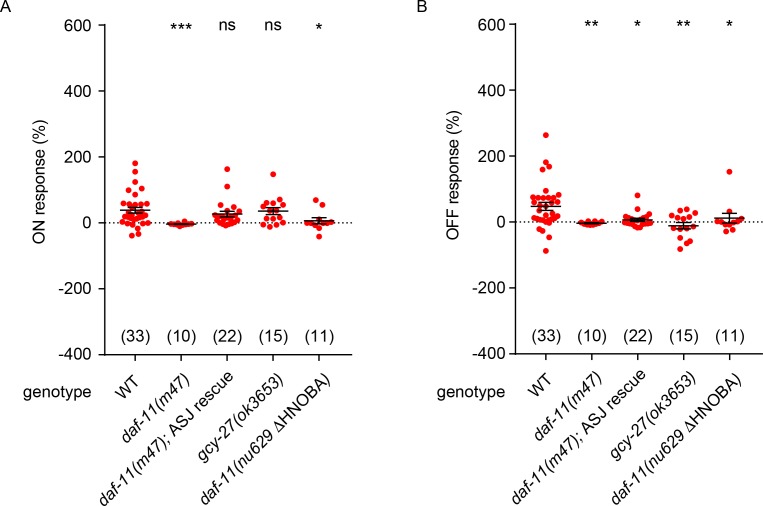
NO response amplitudes for data in Figure 5.(A, B) NO evoked ON (A) and OFF (B) response amplitudes (scatter plots and mean ± SEM) are shown for recordings in Figure 5. ON and OFF response amplitudes are defined in the Methods. For statistical analysis, responses of all mutant genotypes in Figures 4–7 were compared with a common set of wild type controls using Kruskal–Wallis one-way analysis of variance. Significant differences from wild type are indicated as follows: *p<0.05; **p<0.01; ***p<0.001; ns, not significant. The number of animals analyzed is indicated for each genotype.